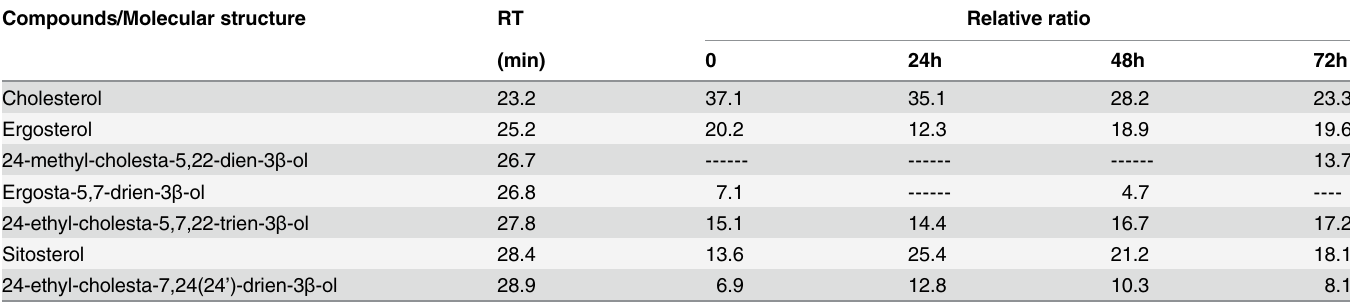
Table 3. Free sterols present in T . cruzi epimastigotes kept in LIT supplemented with dFCS for 0, 24, 48 and 72h. Compounds/Molecular structure